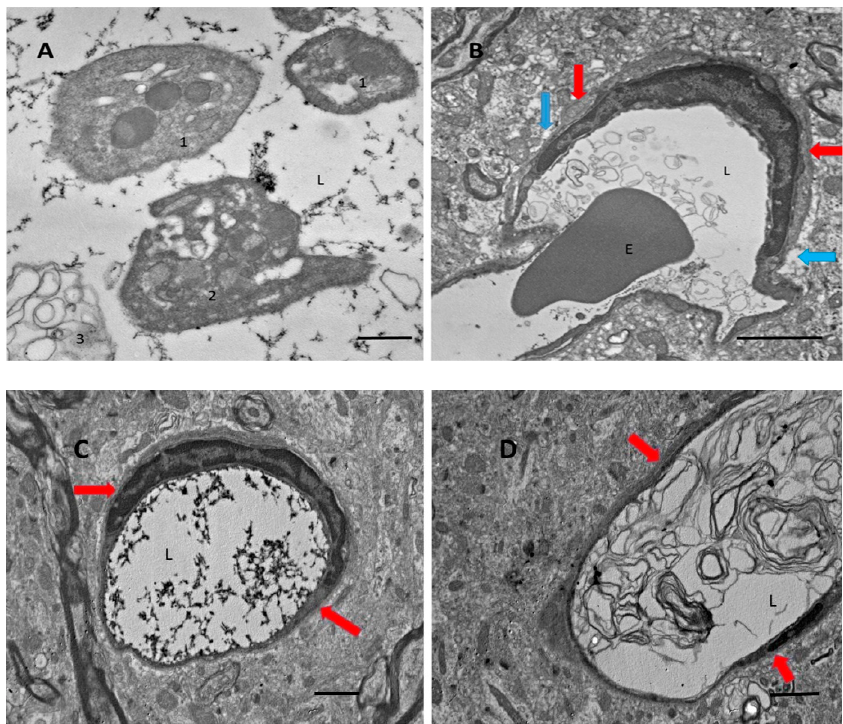
Figure 1. Blood vessels after transient middle cerebral artery occlusion (tMCAO) under the electron microscope. ( A ) Platelets, rounded and stellate (see text). ( B ) Erythrocyte (E) entrapped in debris. ( C ) Fibrin strands in the vessel lumen (L). ( D ) Significant swelling and vacuolar bubbles in the astrocyte endfeet around the blood vessels (blue arrows). Perivascular space (red arrows). Scale bars: ( A ), 500 nm; ( B ), 2 μ m; ( C , D ), 600 nm.